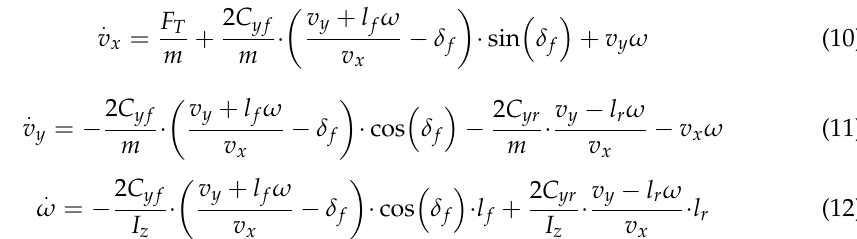
Figure 8. Comparative results of coupling effect on lateral dynamics: ( a ) amplitude-frequency characteristics from 𝐹 (cid:3021) to 𝜔 and 𝛿 (cid:3033) to 𝜔 ; ( b ) open-loop gains from 𝐹 (cid:3021) to 𝜔 .